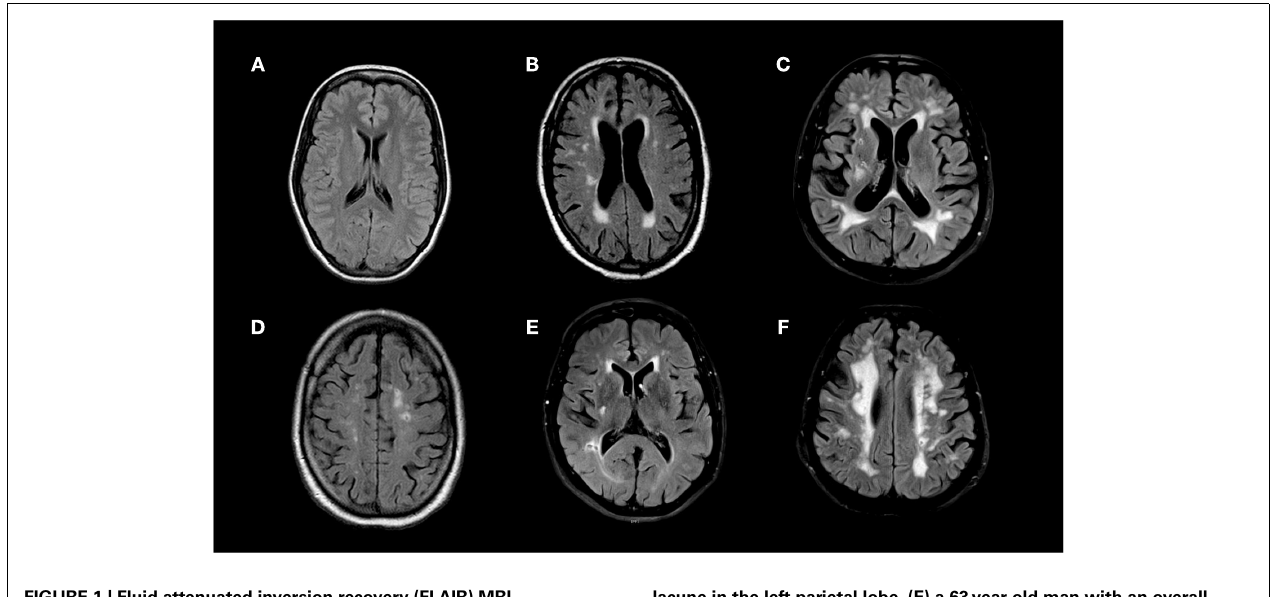
FIGURE 1 | Fluid attenuated inversion recovery (FLAIR) MRI sequences of (A) a 21year old patient with an overallWahlund score of 0, (B) a 51year old patient with an overallWahlund score of 8, (C) a 69year old patient with aWahlund score of 20, (D) a 75year old man with an overallWahlund score of 12 and a 4mm cavitating